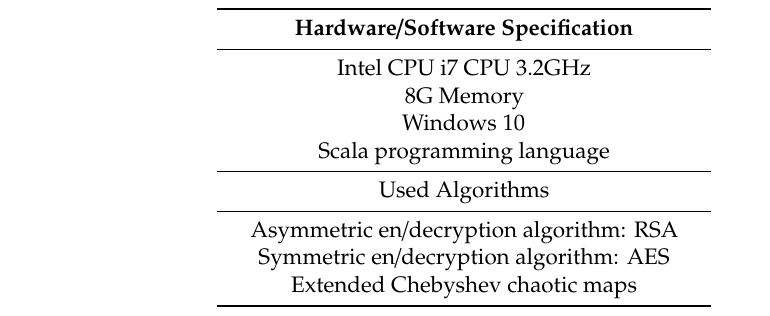
Table 3. Simulation environment.